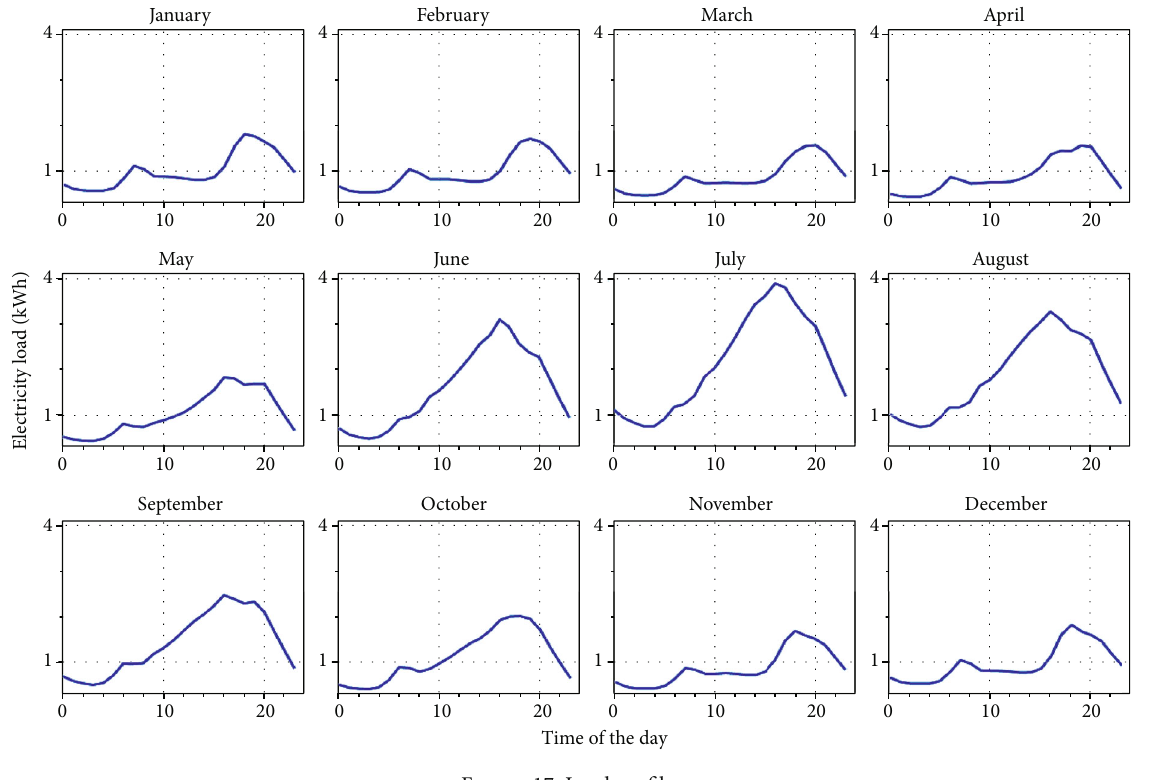
Figure 17: Load pro fi